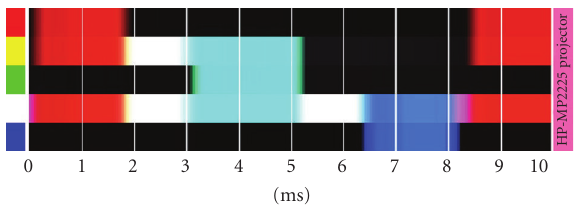
Figure 2: Color-wheel sequences of the HP MP2225 as seen by the synchronized camera with starting exposure times ranging from 0 to 10ms.